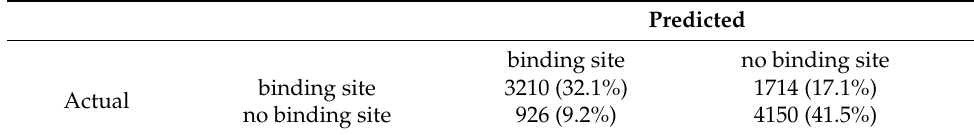
Table A4. Confusion matrix for interaction prediction with our model on the Orthogonal dataset (achieving an AUROC of 0.88, see Table 2). Details as in Table A1. Accuracy = (TP + TN)/ N = 0.797,